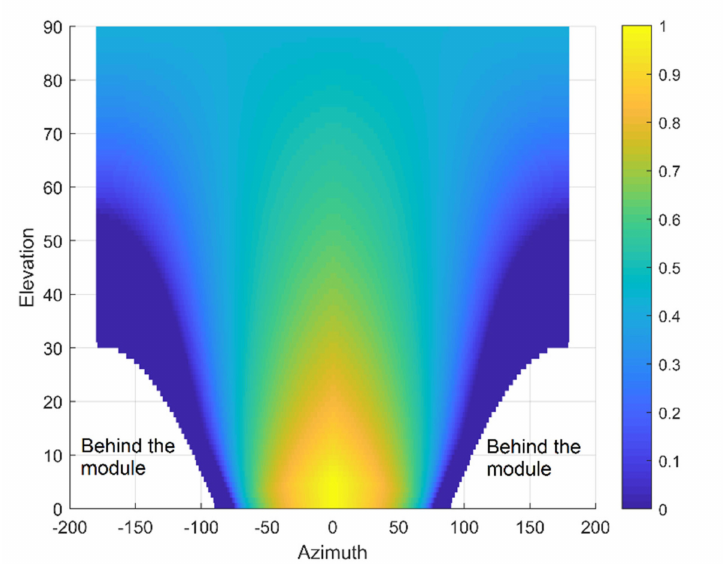
Figure 9. Heat map representation of the shading table. Yellow portions correspond to higher shading factors for the direct irradiance. Blue values correspond to low shading factors for the direct irradiance. The white parts on the bottom left and right corners of the heat map correspond to angles where the sun is behind the module (NaN values).